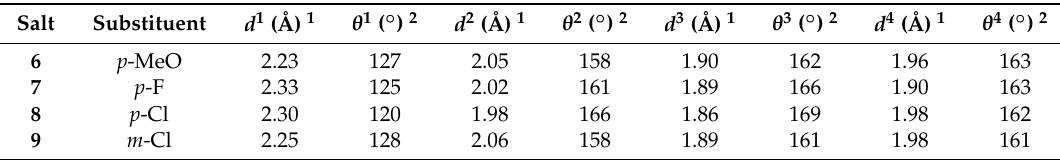
Table 3. Geometrical parameters of methoxy-group-assisted salt bridges and other salt bridges in salts 6 – 9